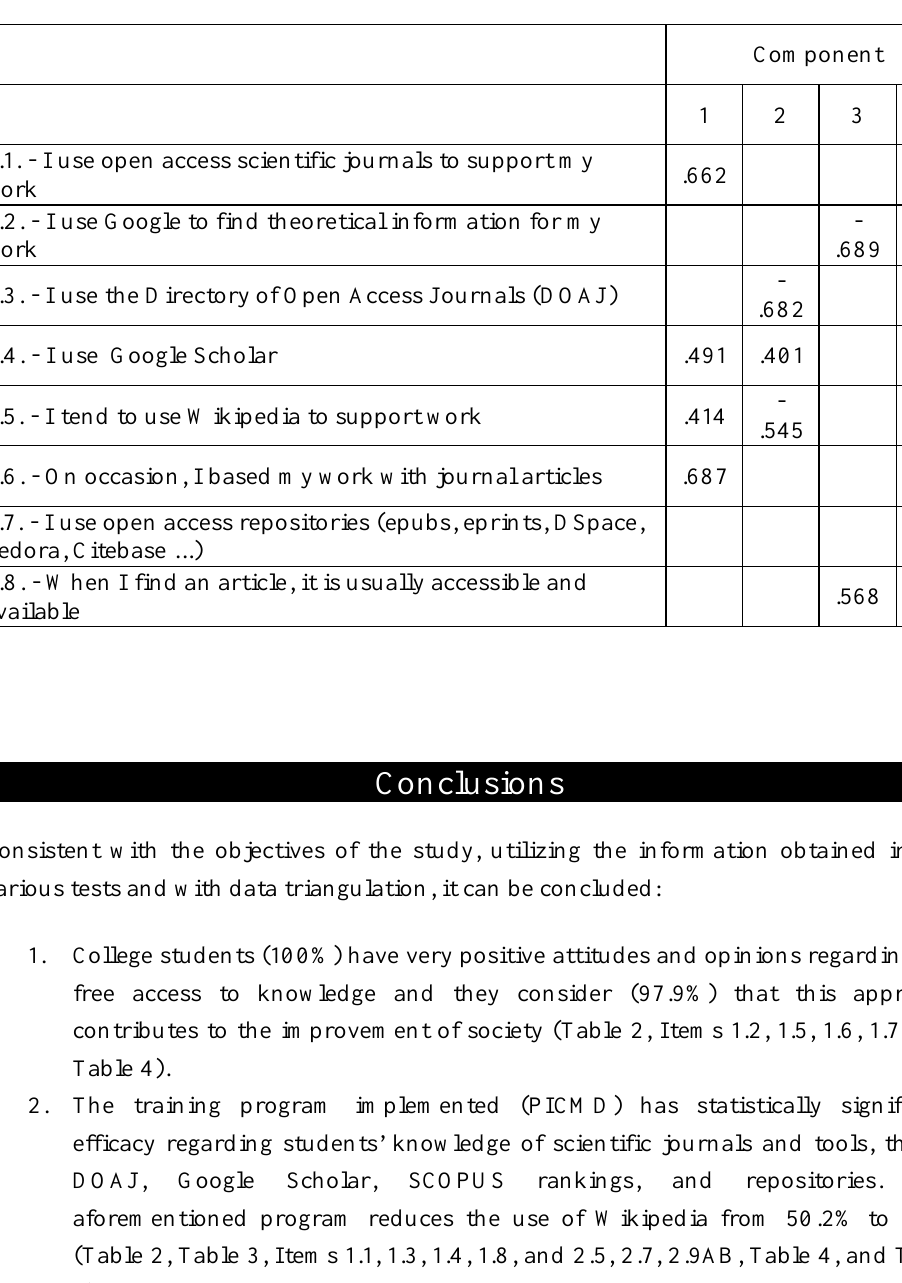
Dimension 2. Rotated Component Matrix. Extraction Method: Principal Components Analysis. Rotation Method: Varimax with